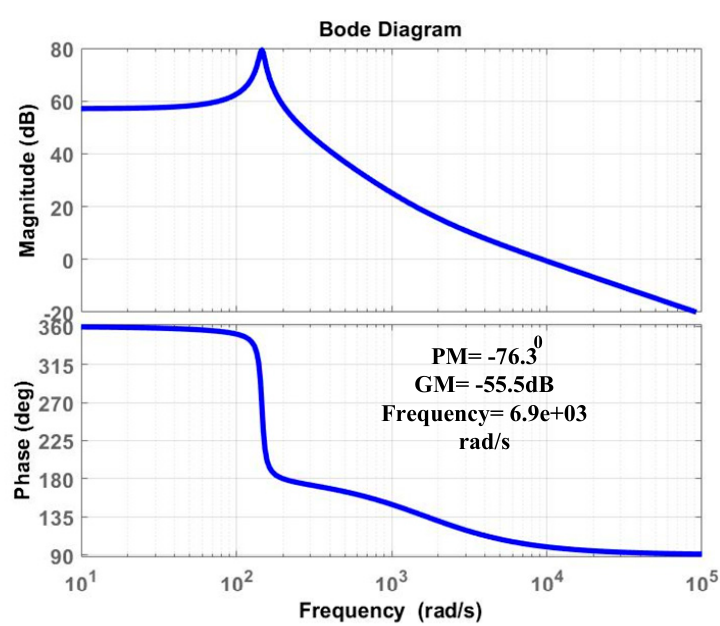
Figure 5. The control-to-output voltage transfer function of the system.